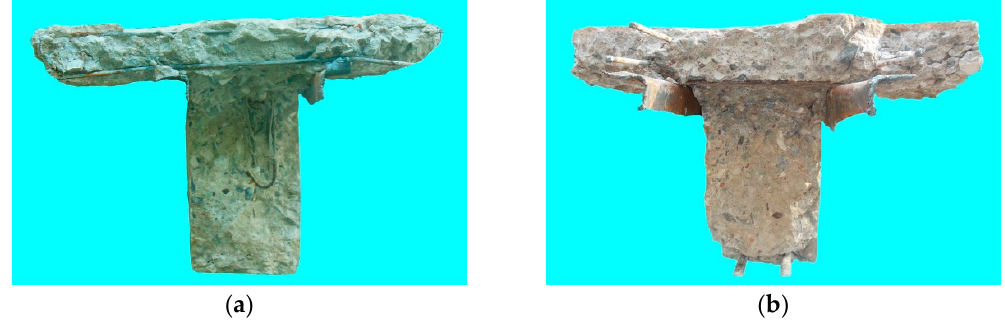
Figure 13. Cut sections of in-filled concrete after the fire test: ( a ) Specimen B3 and ( b ) Specimen B4.